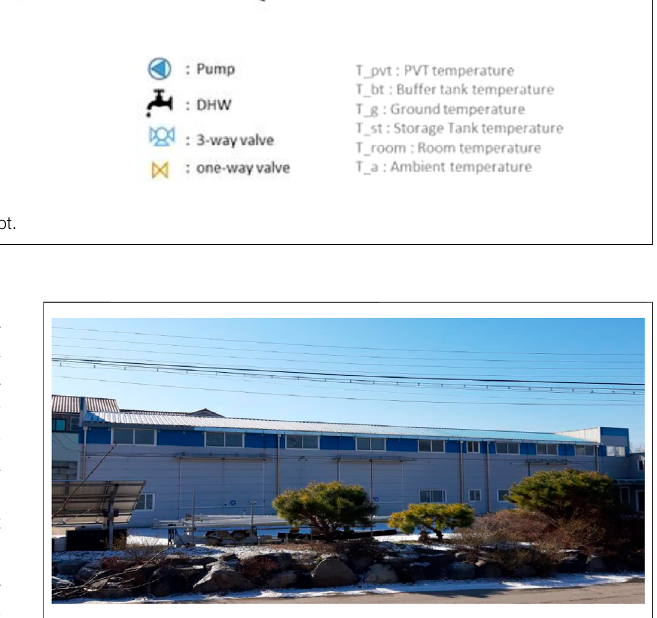
FIGURE 2 | Hybrid solar – geothermal heat pump polygeneration demonstration